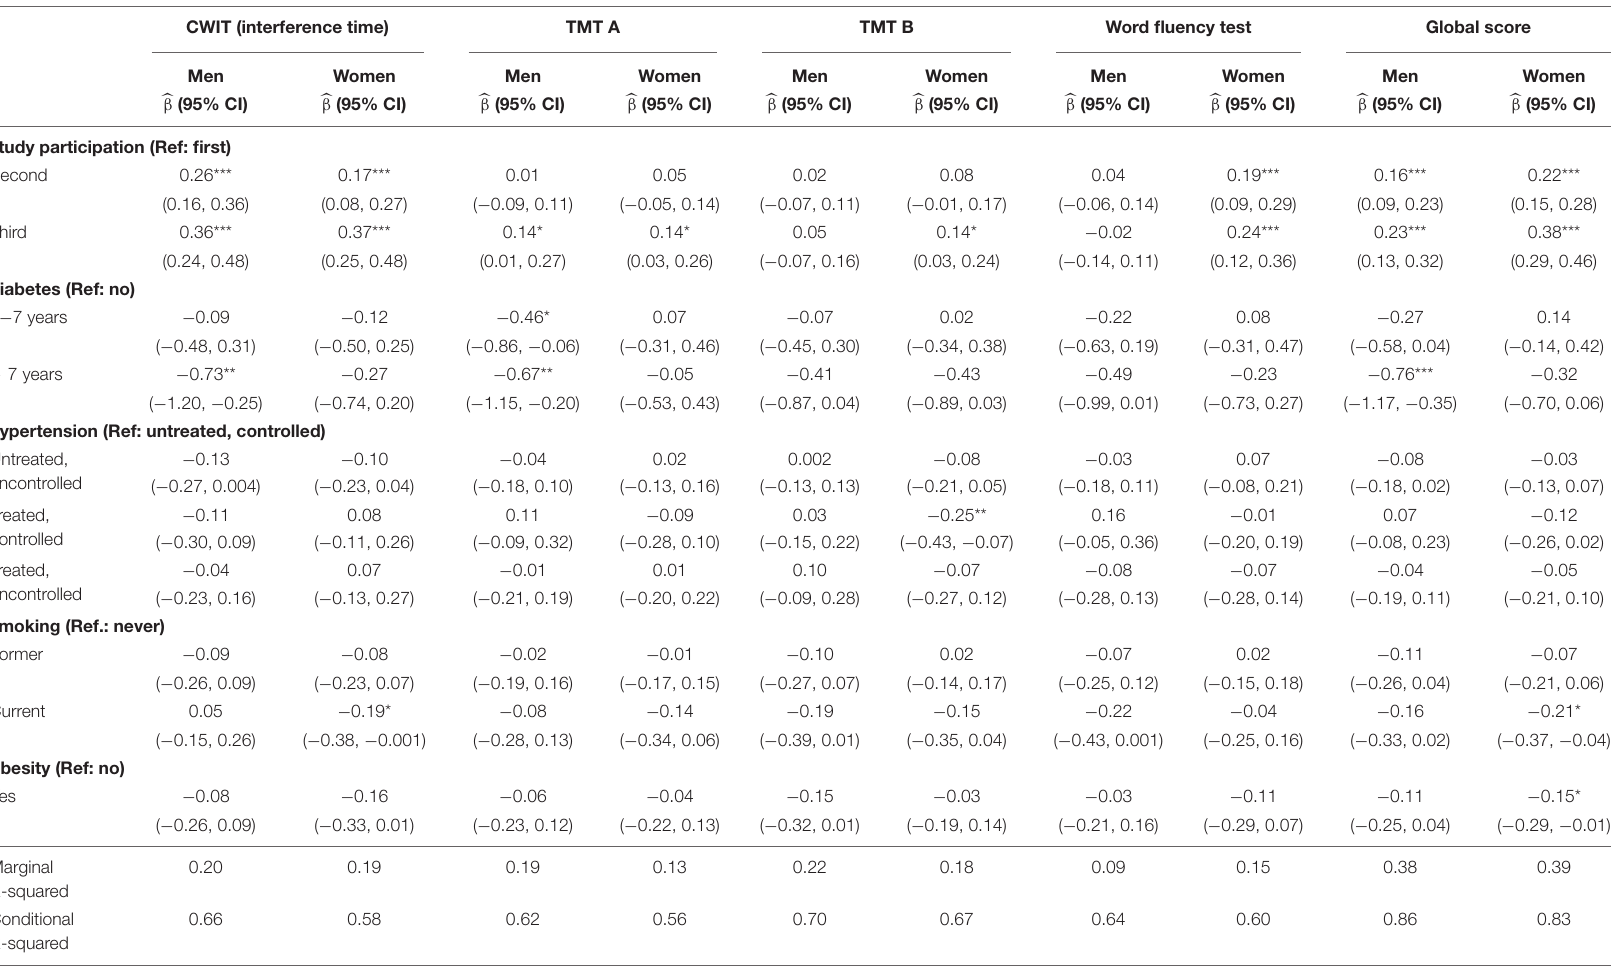
TABLE 3B | Sex-specific effects of risk factors on standardized test results of Color–Word Interference Test (CWIT, interference time), Trail Making Test (TMT) A, TMT B, Word Fluency and the PCA-derived global